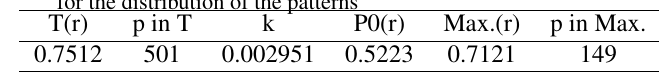
Table 8. Stage 2. Estimated values by the mathematical model for the distribution of the patterns T(r) p in T k P0(r) Max.(r) p in